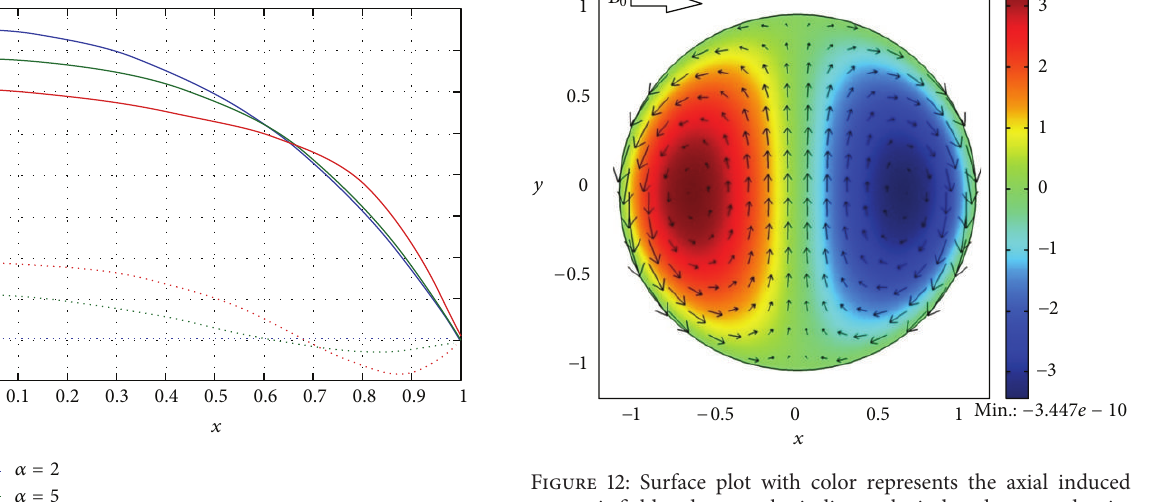
Figure 12: Surface plot with color represents the axial induced magnetic field and arrow plot indicates the induced current density in steady case for Re = 300 , Ha = 2